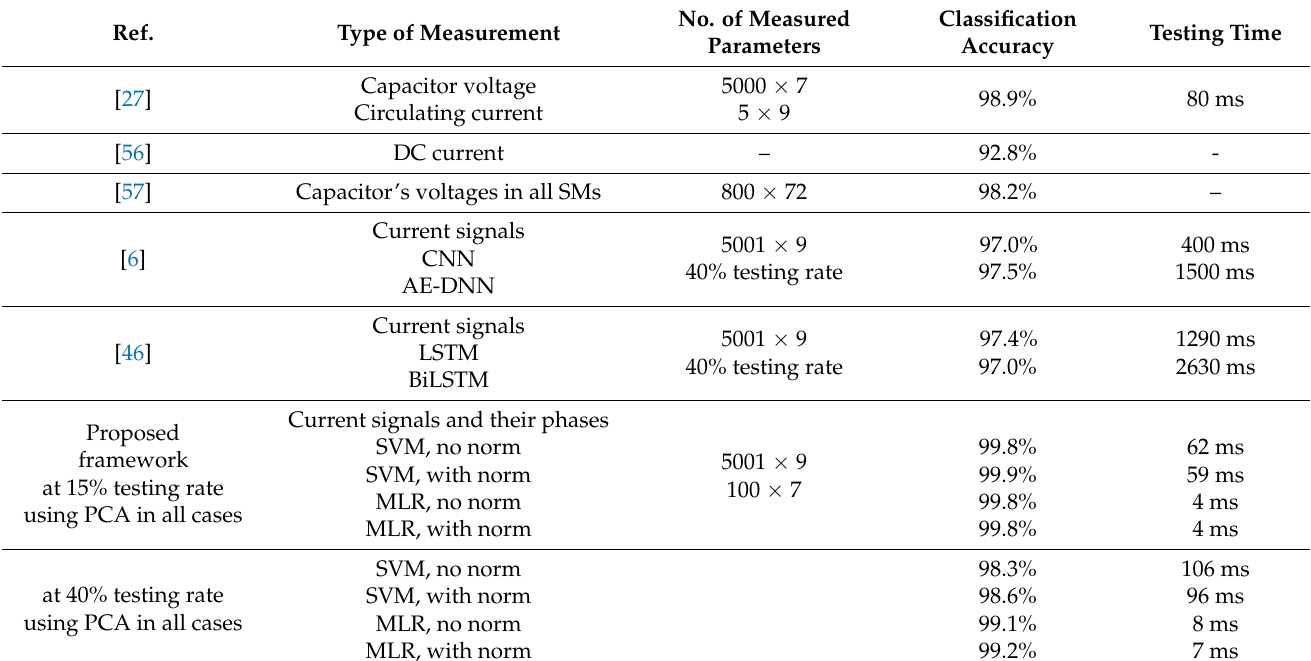
Table 8. Our results with 10-fold cross validation compared with some recently published